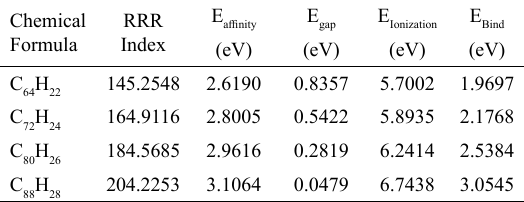
Table 4. Predicting Electron Affinity Energy, Energy Gap, Ionization Energy and Binding Energy through TIM method (1 eV = 1.6 × 10 -19 J